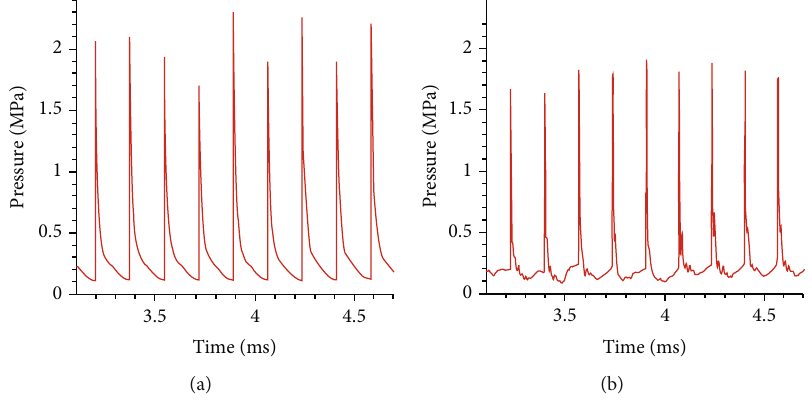
Figure 5: Pressure record curves of monitor points: (a) case 1 and (b) case 2. Table 2: Detonation propagation velocities and detonation wave heights of three di ff erent grid